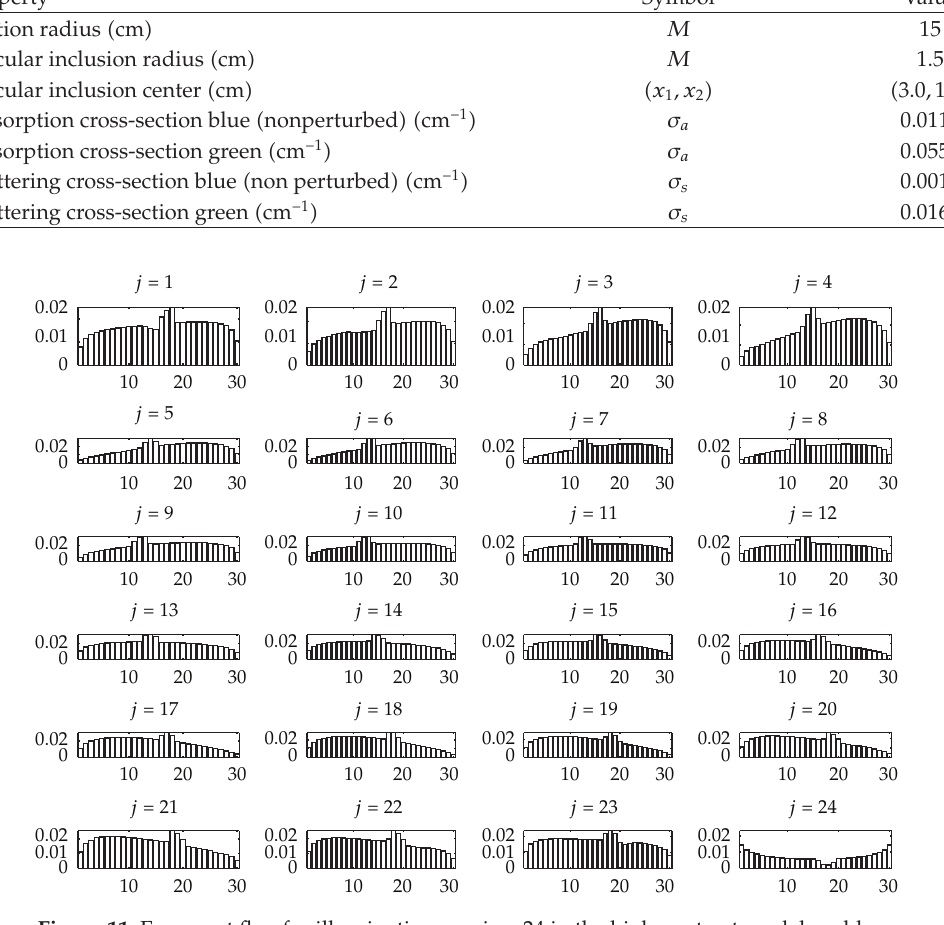
Figure 11: Emergent flux for illumination on view 24 in the high-contrast model